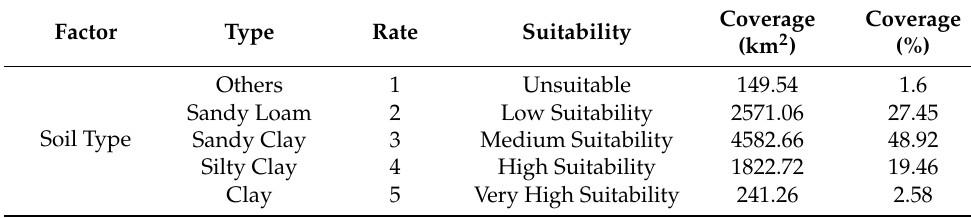
Table 6. Distribution of soil types of suitability